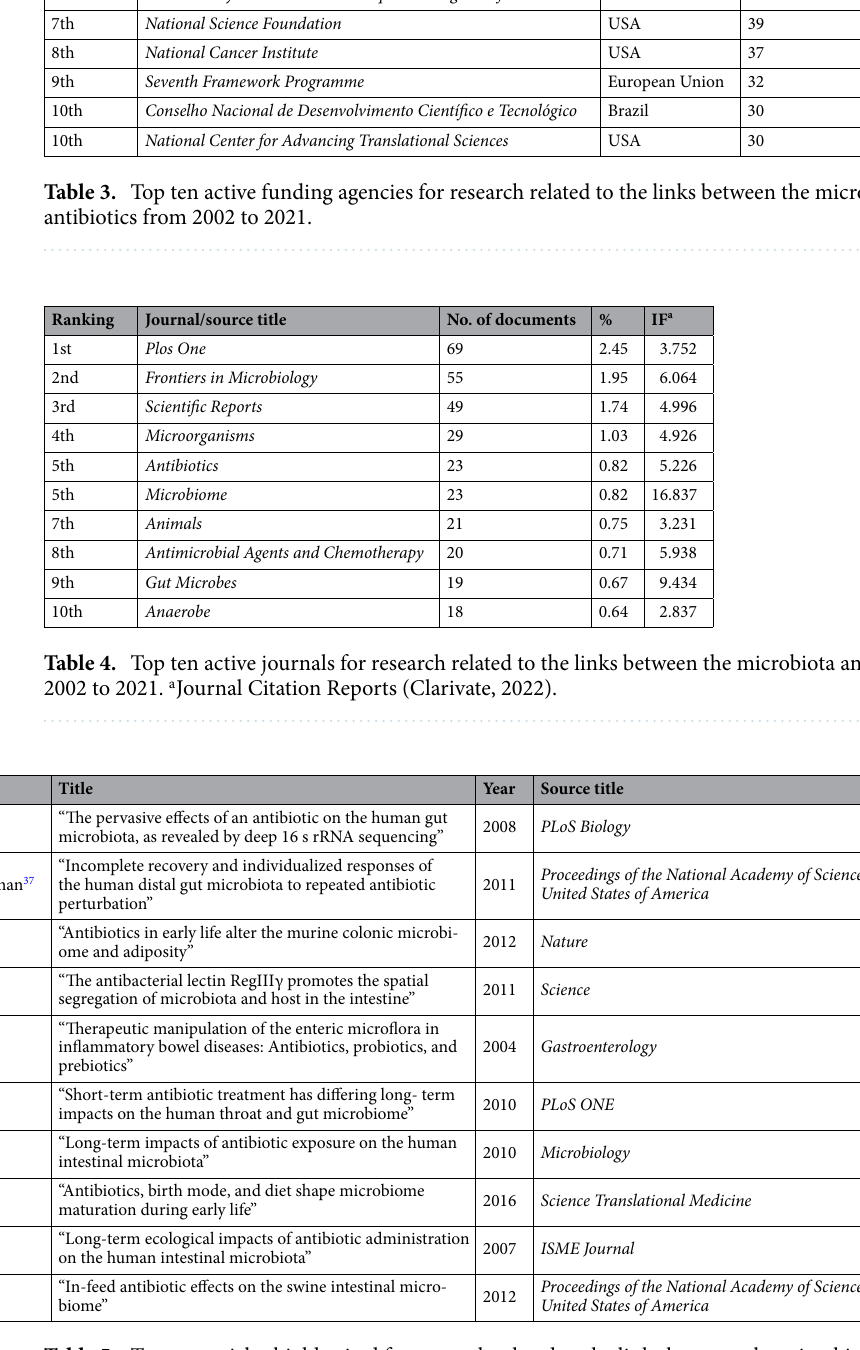
Table 5. Top ten articles highly cited for research related to the links between the microbiota and antibiotics from 2002 to